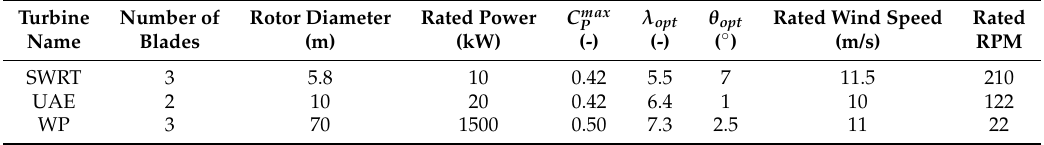
Table 1. Wind turbines model